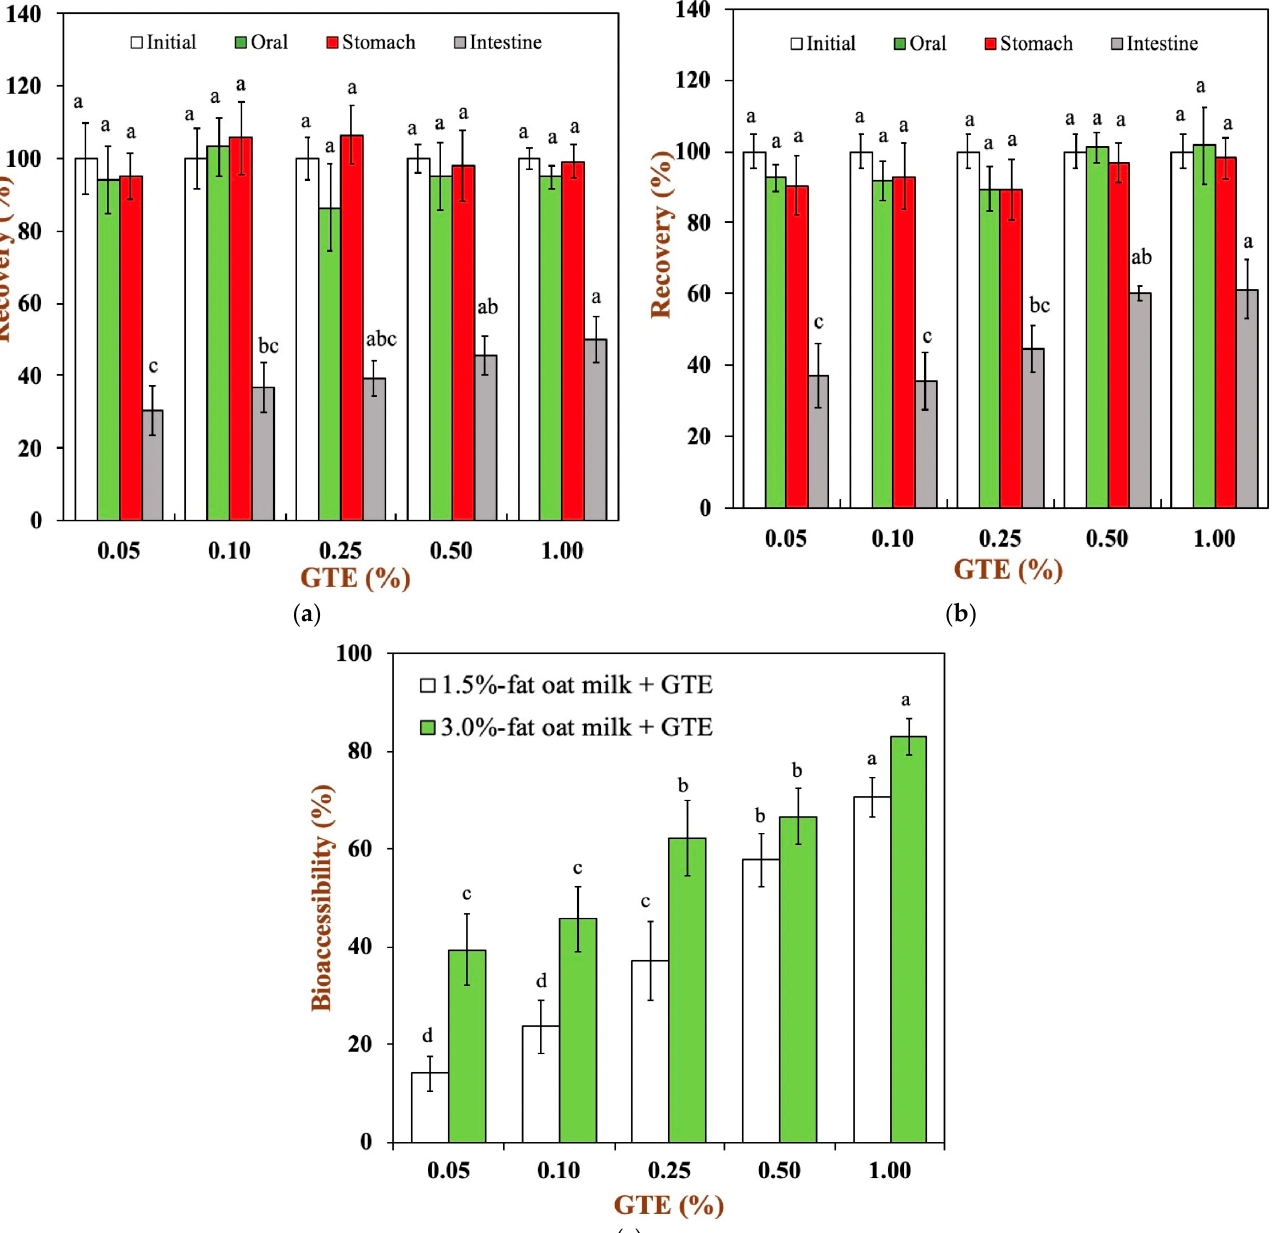
Figure 5. Total polyphenols recovery in oat milk tea model system after exposure to di ff erent